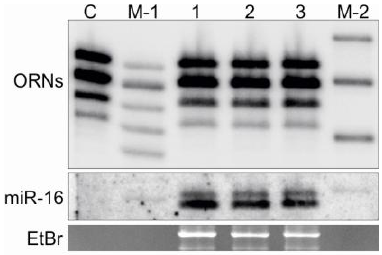
FIGURE 1. The impact of the RNA isolation procedure on the extraction efficiency of LMW RNAs. RNAs were isolated using either a standard TRI reagent extraction (1) or the TRI reagent method with the following modifications: prolonged precipitation with isopropanol at -20°C overnight (2) or precipitation with EtOH/NaAc (3). M denotes end-labeled size markers; 17-, 19-, 21-, 23-, 25-nt synthetic ORNs (M-1) and 20-, 25-, and 30- nt bands of LMW RNA marker from USB (M-2). Staining with ethidium bromide (EtBr) provides a loading control. Hybridization to the abundant endogenous miR-16 provides an additional